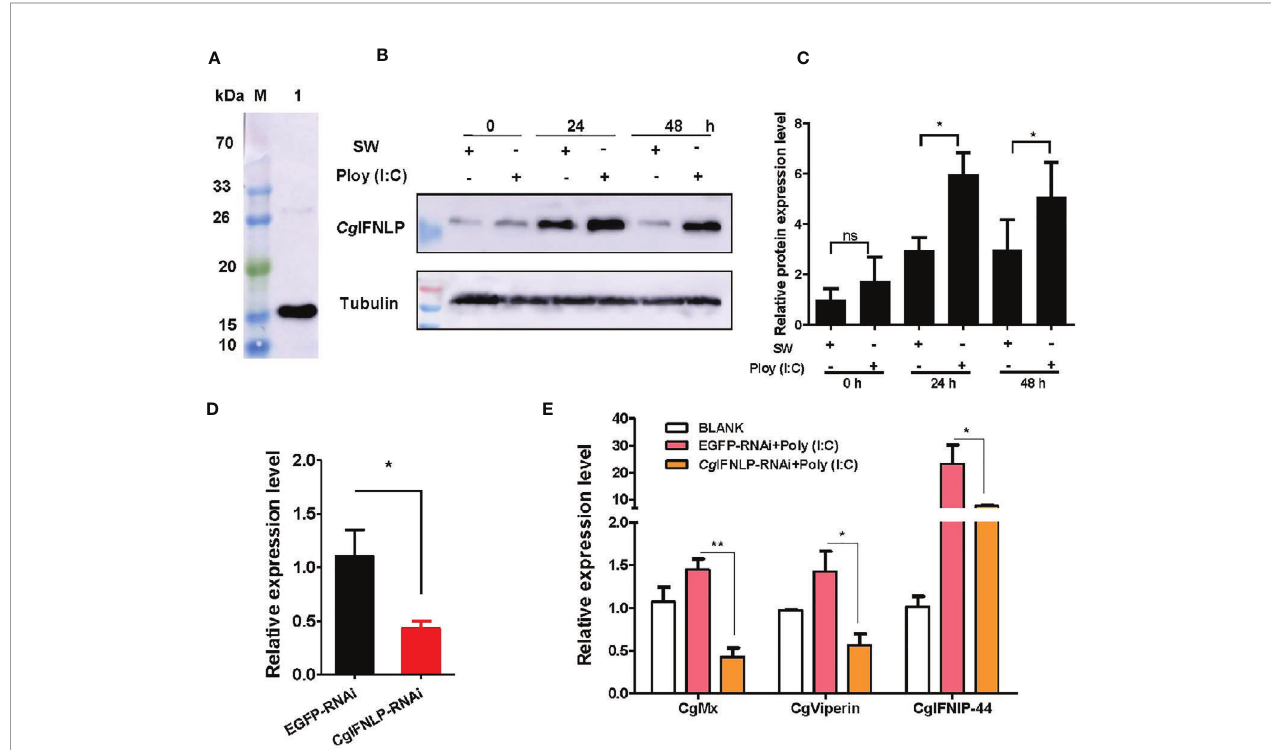
FIGURE 1 | The expression of Cg ISGs in Cg IFNLP – RNAi oysters. (A) The speci fi city of polyclonal antibody for Cg IFNLP examined by Western blot. (B) The protein level of Cg IFNLP in hemocytes after Poly (I:C) stimulation. (C) The grayscale analysis of Cg IFNLP protein after Poly (I:C) stimulation using ImageJ software. (D) The ef fi ciency of Cg IFNLP – RNAi in hemocytes (EGFP – RNAi was used as control). (E) The mRNA expressions of Cg Mx, Cg Viperin, and Cg IFNIP-44 in Cg IFNLP – RNAi oysters after Poly (I:C) stimulation. Vertical bars represent the mean ± SEM (N = 3). * p < 0.05; ** p < 0.01; ns, not signi fi